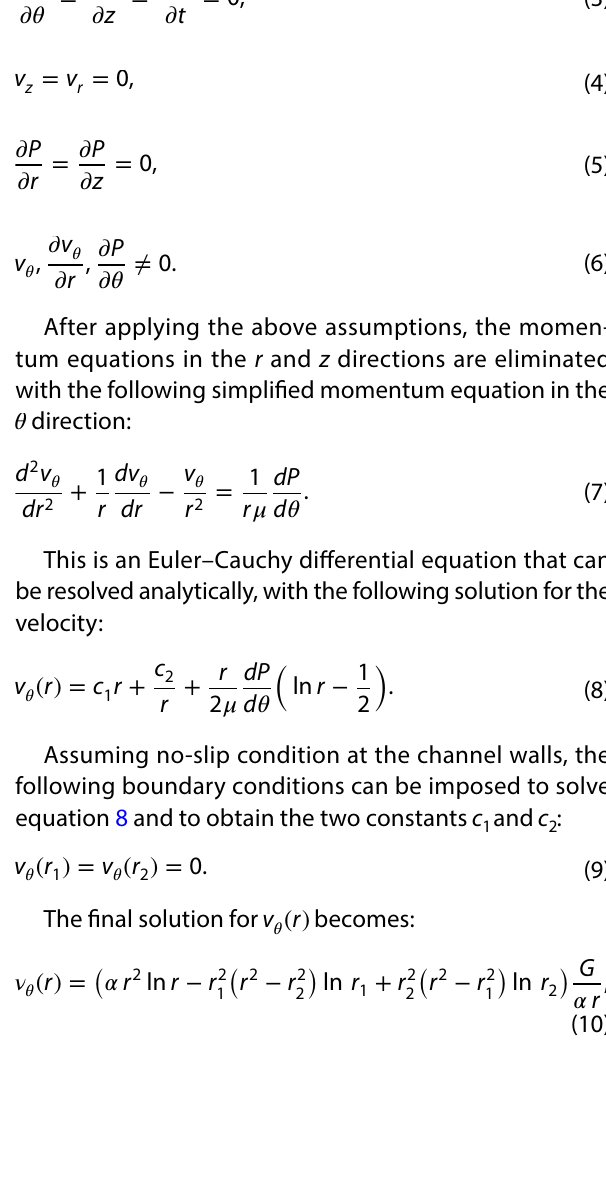
Fig. 5 Reynolds number versus the imposed voltage for both oils (SO50 and SO100), indicating a power law